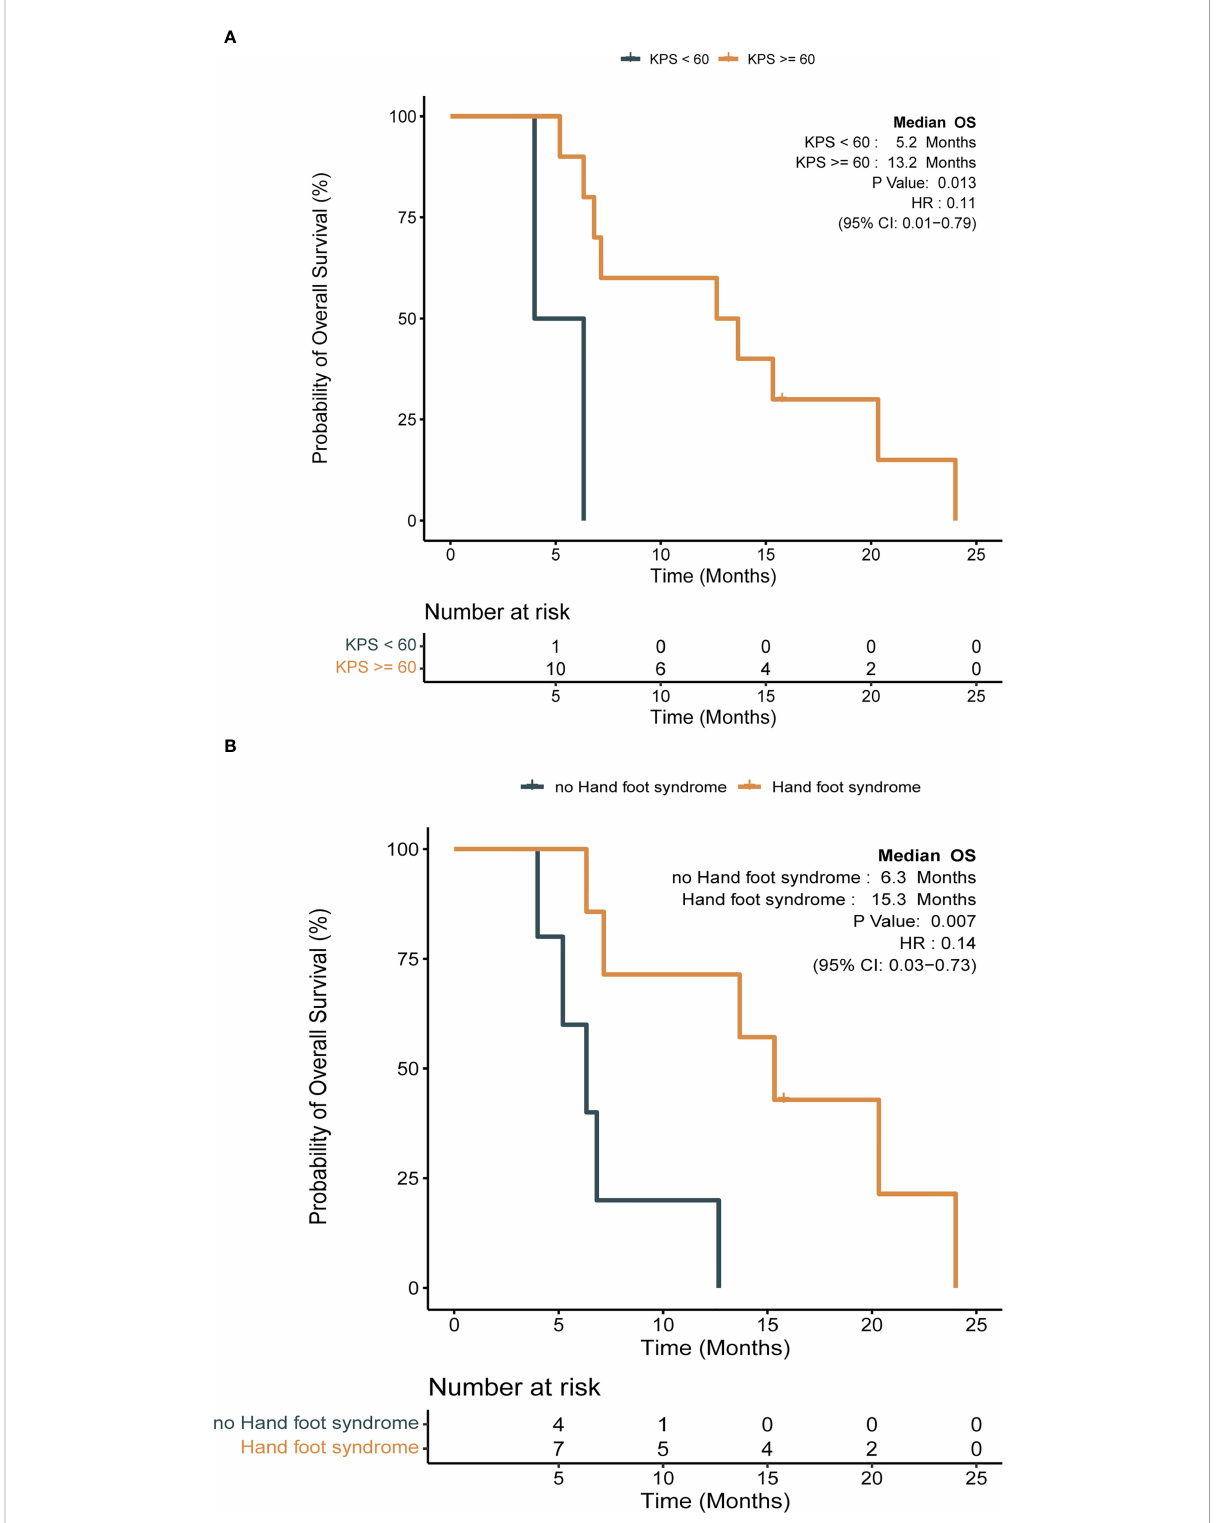
FIGURE 4 Impact of clinical factors on survival with Kaplan-Meier survival analysis in anlotinib group (log-rank test, P < 0.05 ). (A) Impact of Karnofsky performance scale (KPS) on OS; (B) impact of hand and foot syndrome (HFS) on